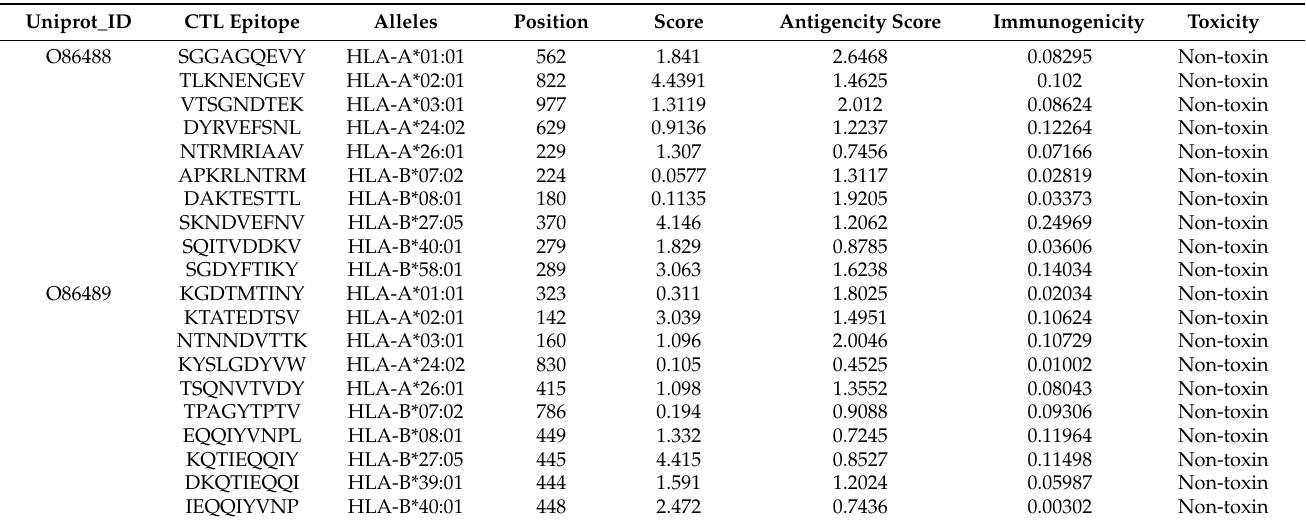
Table 2. Predicted CTL epitopes from S. aureus cell wall adherence proteins, SdrD and SdrE to design multi-epitope vaccine construct with their corresponding MHC Class I alleles and their immunogenic